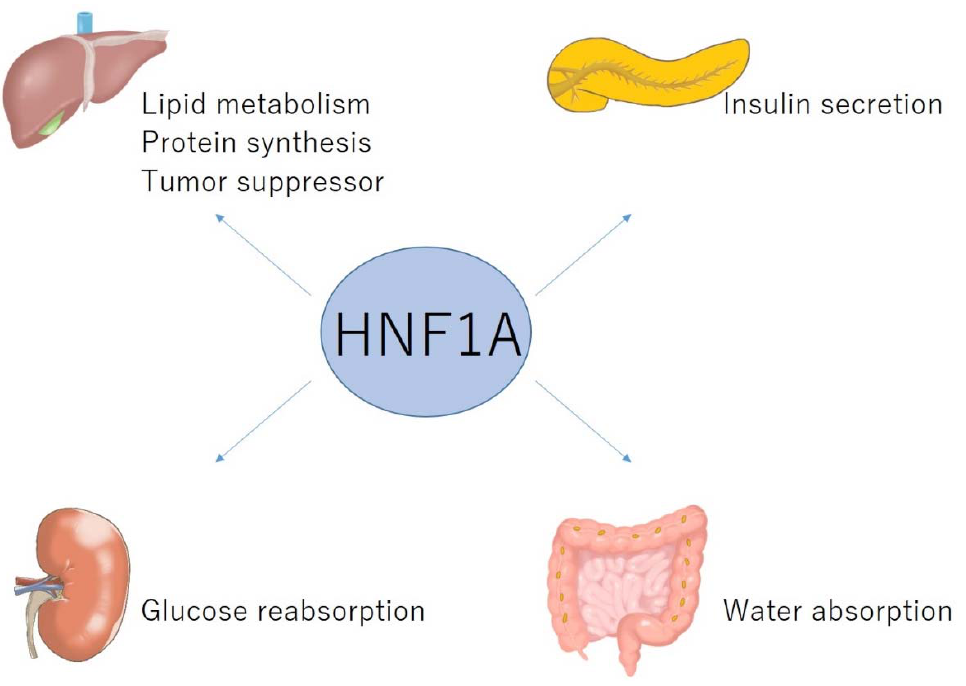
Figure 1. Physiological role of HNF1A in the liver, pancreas, kidneys, and